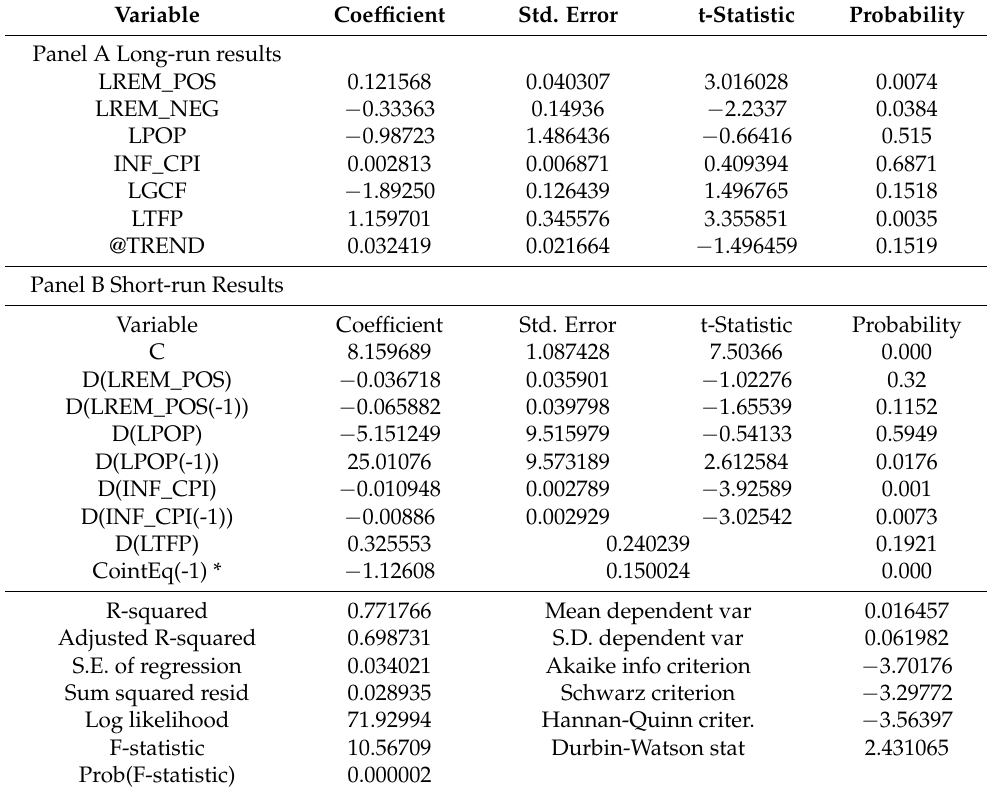
Table 7. NARDL long-run and short-run results.